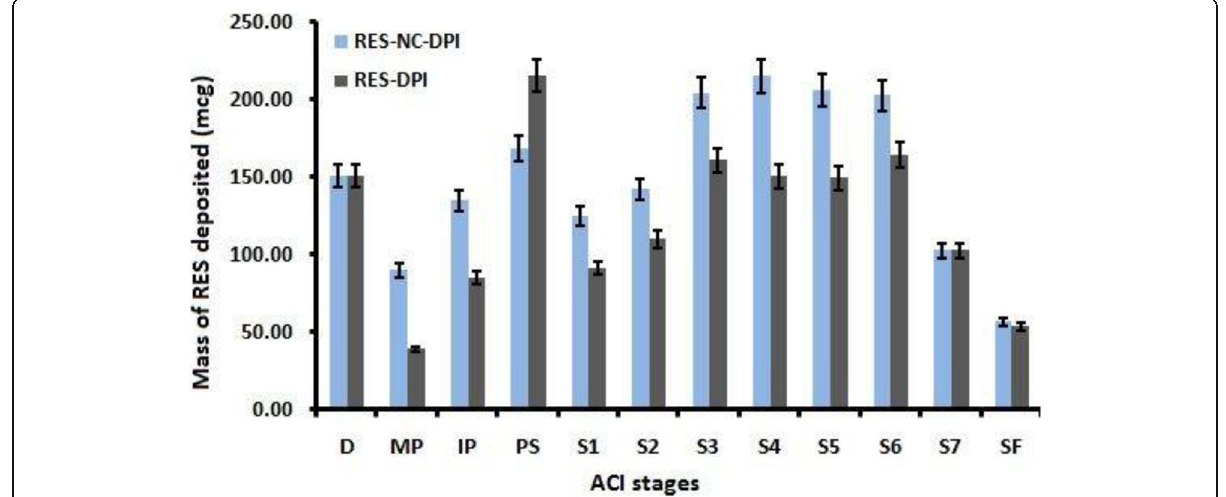
Fig. 6 Mass of RES deposited within the ACI assembly using the Rotahaler® inhaler device at a flow rate of 60